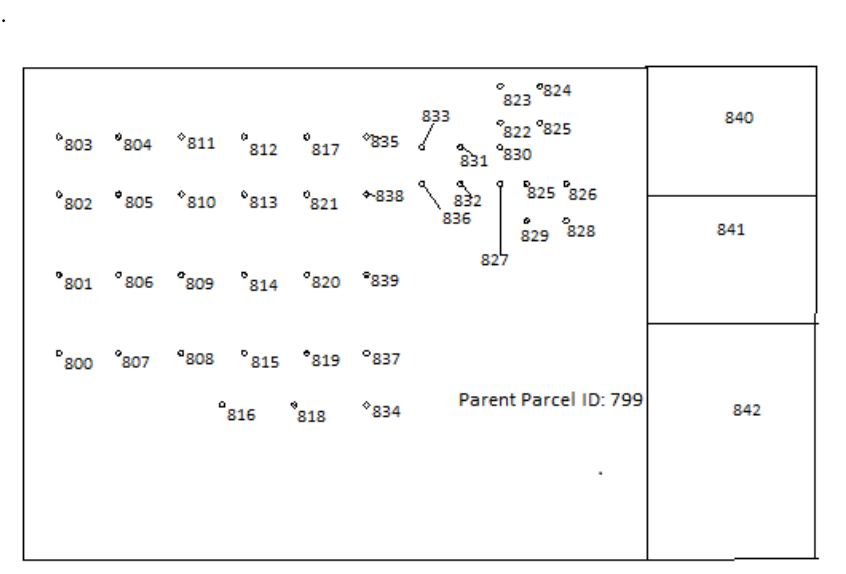
Figure 10. A traditional 2D method of registration for complex multi-use rights (image created by author).